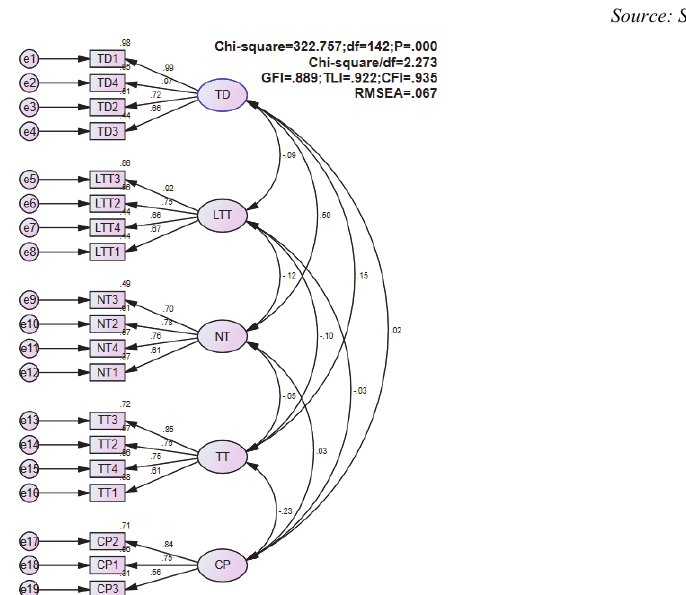
Fig. 1. CFA analysis results according to standardized